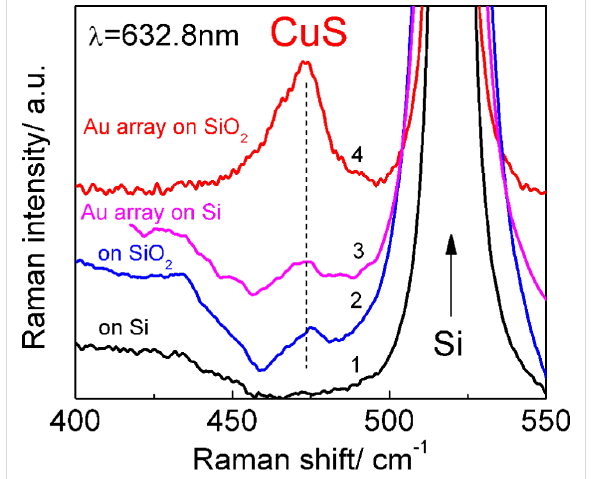
Figure 5: Raman spectra of CuS NCs deposited on bare Si, 75 nm SiO 2 layer on Si, and on Au arrays fabricated on Si and SiO 2 layer on Si measured with 632.8